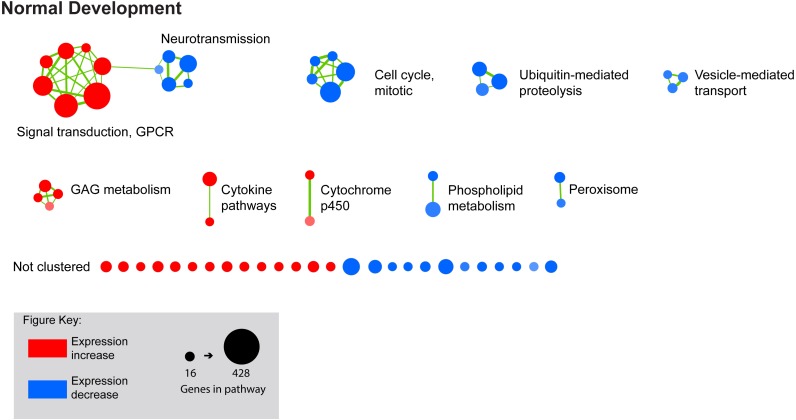
Enrichment map for highly clustered pathways in normal eye development.Gene set enrichment analysis revealed 61 biological pathways that can be functionally grouped into 10 clusters using a co-efficient of similarity altered during the 10 days of normal eye development in retina/RPE/choroid. Note: Each node represents a biological pathway from File S1. The colour of each node emphasises the direction of expression and normalised enrichment score (NES). Node size is relative to the number of genes in the pathway. Thickness of the connections (green) between each node reflects the degree of similarity between each gene set. Twenty-six pathways did not meet the clustering similarity coefficient of 0.5 and hence are not shown here. Note cluster names: GAG, glycosaminoglycan; GPCR, g-protein coupled receptors.